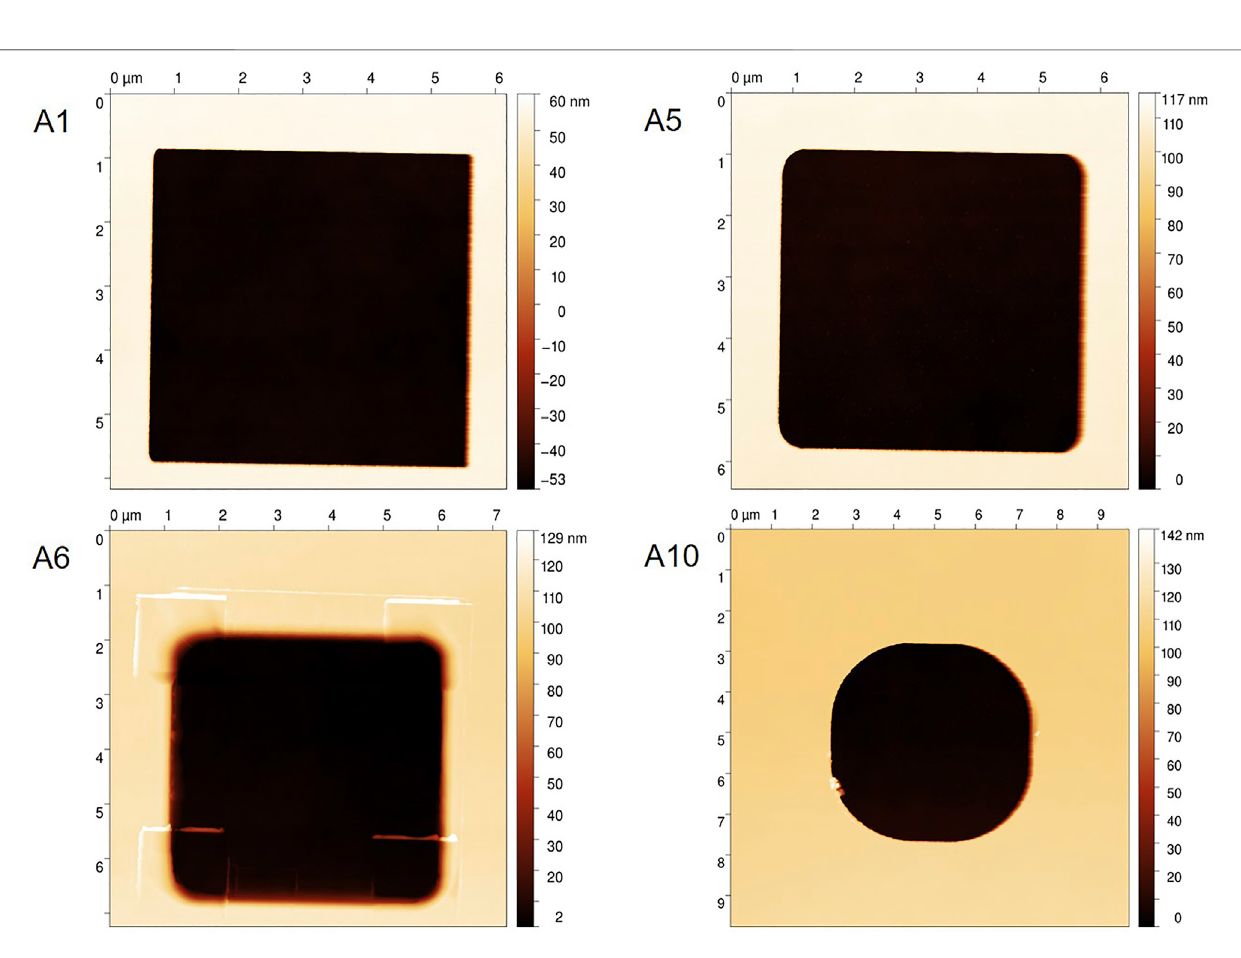
FIGURE 7 | AFM measurements of structures in row